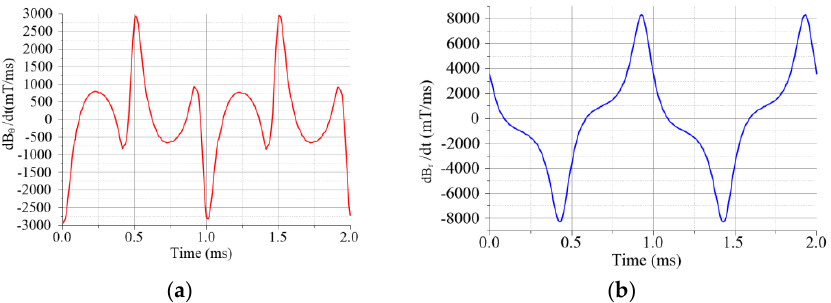
Figure 15. The first derivative of the radial and axial flux density in the outer rotor core. ( a ) Radial. ( b ) Axial.